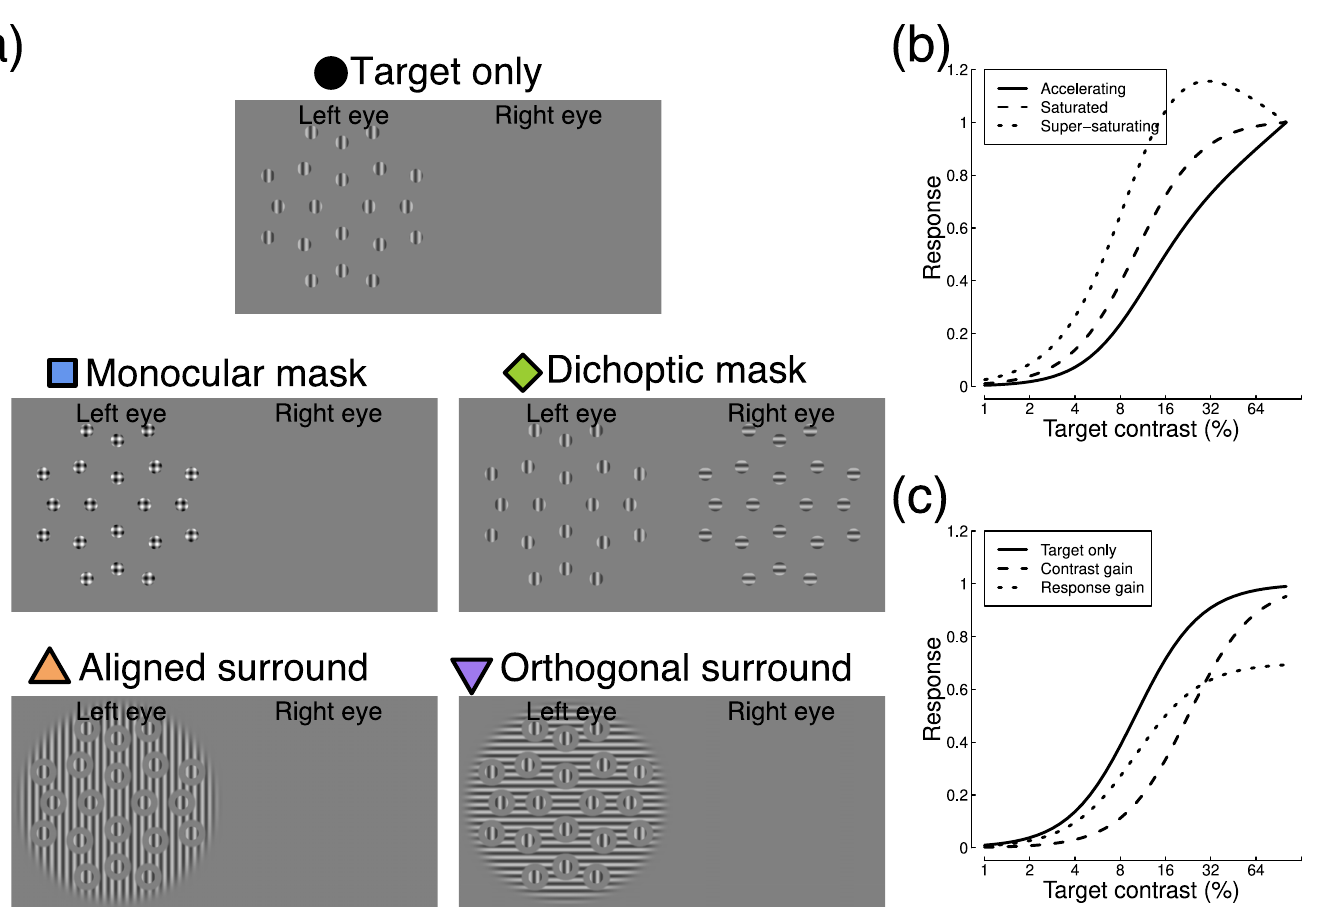
Fig 1. Example stimuli and illustration of contrast response functions. Panel A shows five stimulus arrangements, illustrating how a vertical target pattern can be combined with four different mask types. Panel B shows three varieties of contrast response function, that either continue to accelerate (solid line), saturate (dashed line) or super-saturate (dotted line) across the range of displayable stimulus contrasts. Panel C illustrates a contrast gain (dashed line) and a response gain (dotted line) shift, relative to a baseline response (solid line).